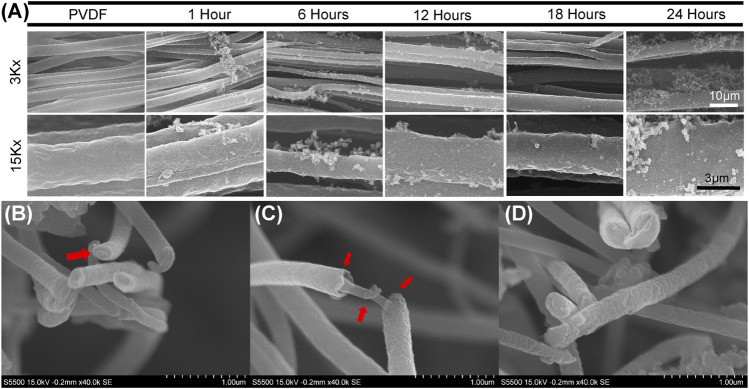
Scanning electron micrography of PPy coating morphology on aligned PVDF fibers (A) Morphology of uncoated, aligned PVDF fibers and PPy-coated PVDF fibers by PPy polymerization for 1, 6, 12, 18, 24 h. Scanning electron micrographs at two different magnifications (3,000x and 15,000x) show coating stabilization and some PPy debris accumulation around PVDF fibers over time (B,C and D) Micrographs of PVDF electrospun fibers after PPy coating for 18 h (B and D) Cross sections of fibers with PVDF fibers not distinguishable from the PPy coating, while (C) imaging along the length of fibers shows formation of the core-shell structure after coating.